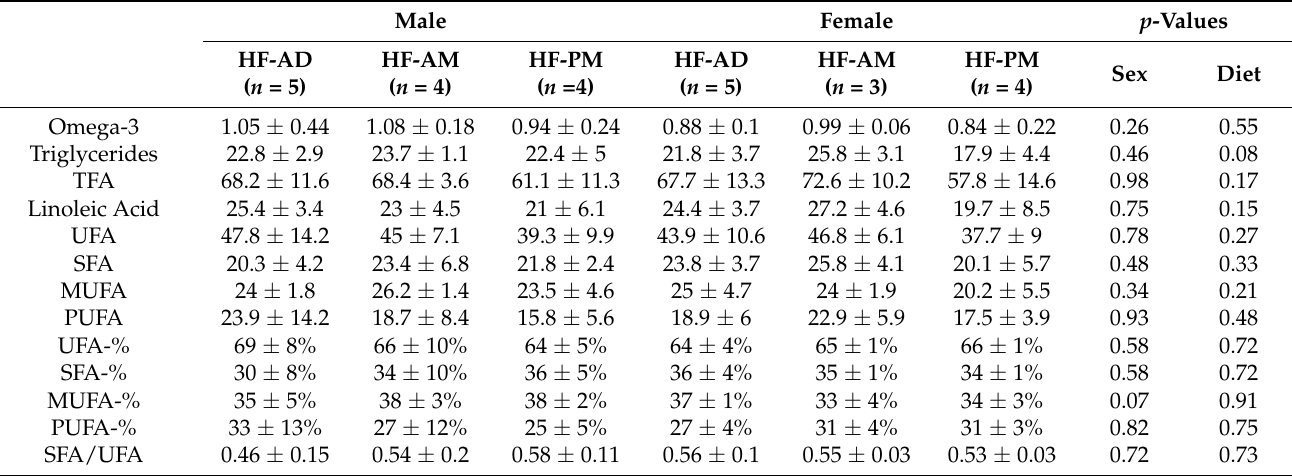
Figure 4. Heatmaps showing mean values of auto-scaled metabolites for both male and female high-fat ad libitum (HF-AD), high-fat morning time-restricted (HF-AM), and high-fat evening time-restricted (HF-PM) groups for different sexes in liver, heart, and adipose tissues of Nile grass rats ( n = 3–5 animals per group). The red and blue colors denote concentrations above and below the indicated metabolite mean concentration value, respectively, with darker colors indicating values farther from the mean. Adipose lipids expressed no statistically significant differences in metabolite concentrations in response to TRF. Significant main effects of diet and sex ( p < 0.05) in metabolite concentrations from two-way ANOVA after post-hoc testing are also shown. Abbreviations: Tg = triglycerides; PC = phosphatidylcholine; SM = sphingomyelin; PE = phosphatidylethanolamine; LA = linoleic acid; DHA = docosahexaenoic acid; MUFA = monounsaturated fatty acids; PUFA = polyunsaturated fatty acids; UFA = unsaturated fatty acids; SFA = saturated fatty acids; Om3 = omega-3 fatty acids; TFA = total fatty acids; TC = total cholesterol; 3-hydroxy. = 3-hydroxybutyrate; Gmi/Gma = ratio of glutamine to glutamate. Partial correlation analysis revealed several metabolites that were significantly cor- related with diet in each of the TRF groups (Figures 3 and 4). Lower concentrations of both cardiac and hepatic TFA and UFA were strongly associated (R ≥ |±0.482|; p ≤ 0.05) Table 5. Adipose tissue metabolite concentrations (mM) indicated as mean ± standard deviation for both male and female high-fat ad libitum (HF-AD), high-fat morning time-restricted (HF-AM), and high-fat evening time-restricted (HF-PM)